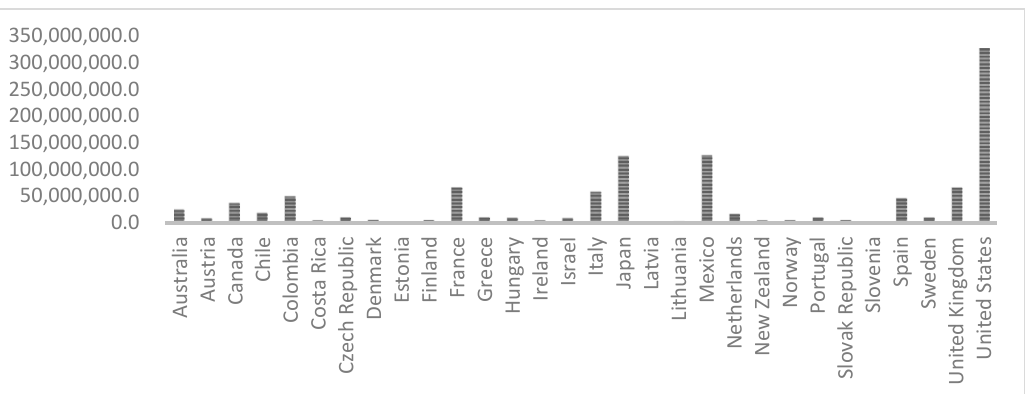
Figure 1. OECD sample countries by the number of inhabitants. Source: Retrieved from [58] and adopted by authors.